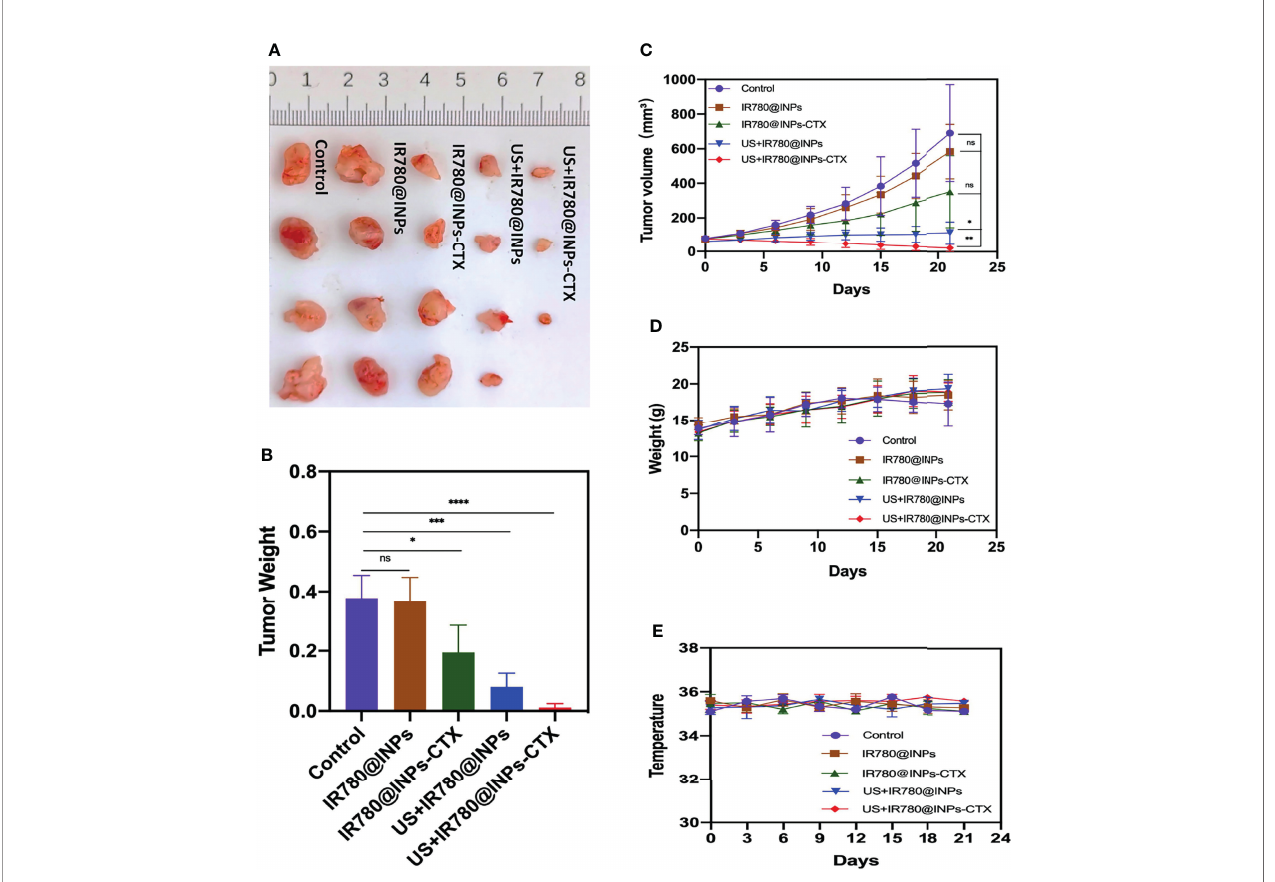
FIGURE 5 | (A) Anatomical image of tumors in different groups of mice after 21 days of treatment. (B) Weight of isolated tumors in different treatment groups after 21 days of therapy. (C) Volume of isolated tumors after 21 days of therapy. (D) Changes in body weight of mice during treatment. (E) Changes in mice body temperature during treatment. ns, P > 0.05; *P < 0.05; **P < 0.01; ***P < 0.001; ****P <